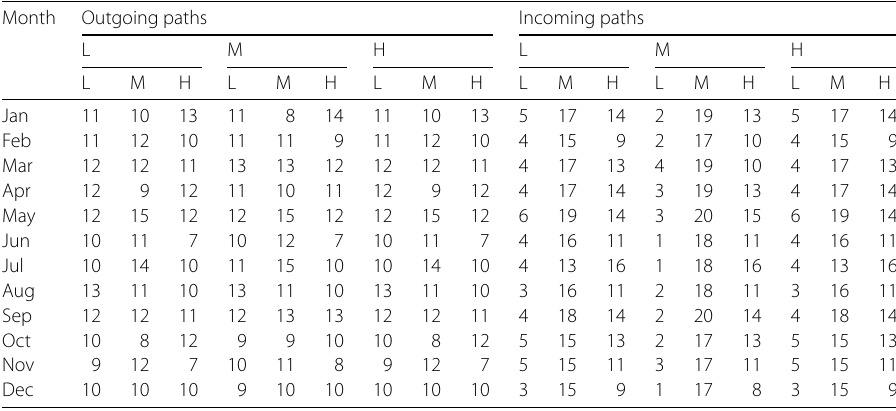
Table 12 Number of rejected test for each month and risk pair: the first row indicates the rating of the starting node of the path, the second row the rating of the target node for outgoing (left) and incoming (right) paths